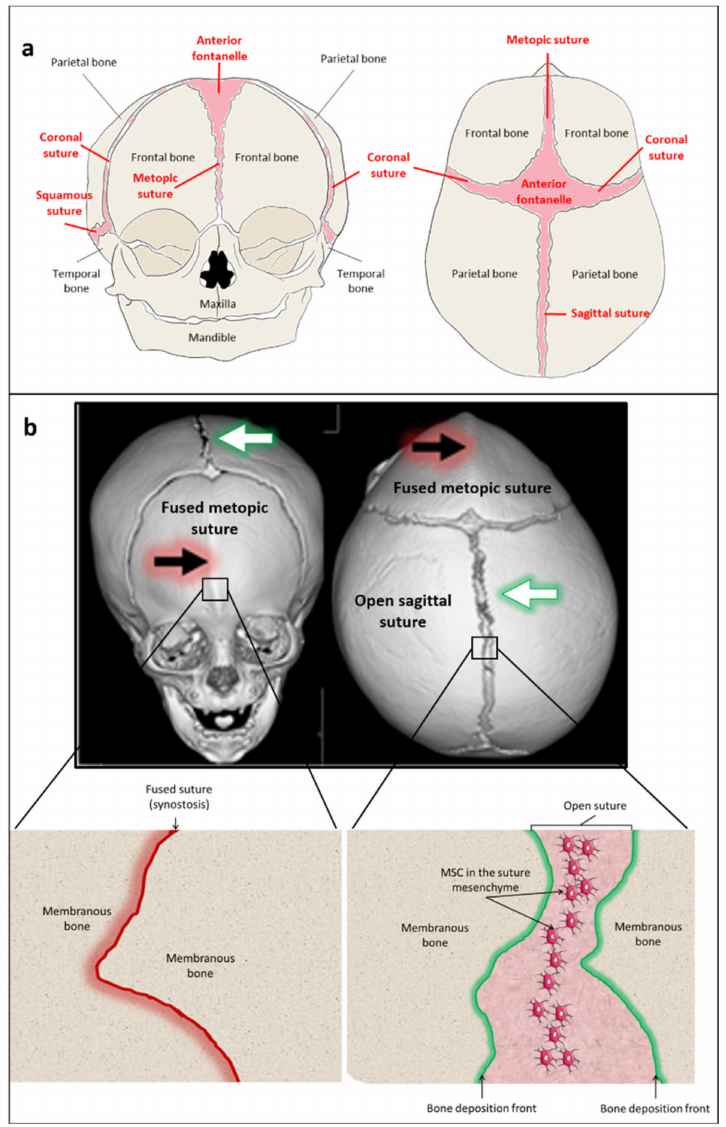
Figure 1. Skull sutures and craniosynostosis. The figure shows a structural and pathophysiological overview of craniosynostosis. ( a ) skull bones in the newborn skull, shown in frontal ( left ) and superior ( right ) views, are kept together by sutures (shown in pink); note that the frontal bone originates as two distinct bony pieces kept together by the metopic suture, which ossifies during early postnatal life. Fontanelles (i.e., palpable soft spots in the newborn skull) are found at crossroads between intersecting sutures and cause the skull to be elastic as needed to adapt dynamically to the rapid brain growth underneath. ( b ) 3D reconstruction of a patient’s skull CT (computerized tomography) showing a synostosis of the metopic suture (the second most prevalent nonsyndromic craniosynostosis (CS), see text for details), in frontal ( left ) and superior ( right ) views; black arrows indicate the fused metopic suture white arrows indicate the open sagittal suture. The magnifications in the lower panels represent a diagram of the tissue architecture at the fused ( left ) and open ( right ) suture sites. Mesenchymal stromal cells (MSC) are viable within the open suture mesenchyme until the suture is ossified. Informed consent by both the parents of the patients was obtained prior to use the CT scan for assembling the